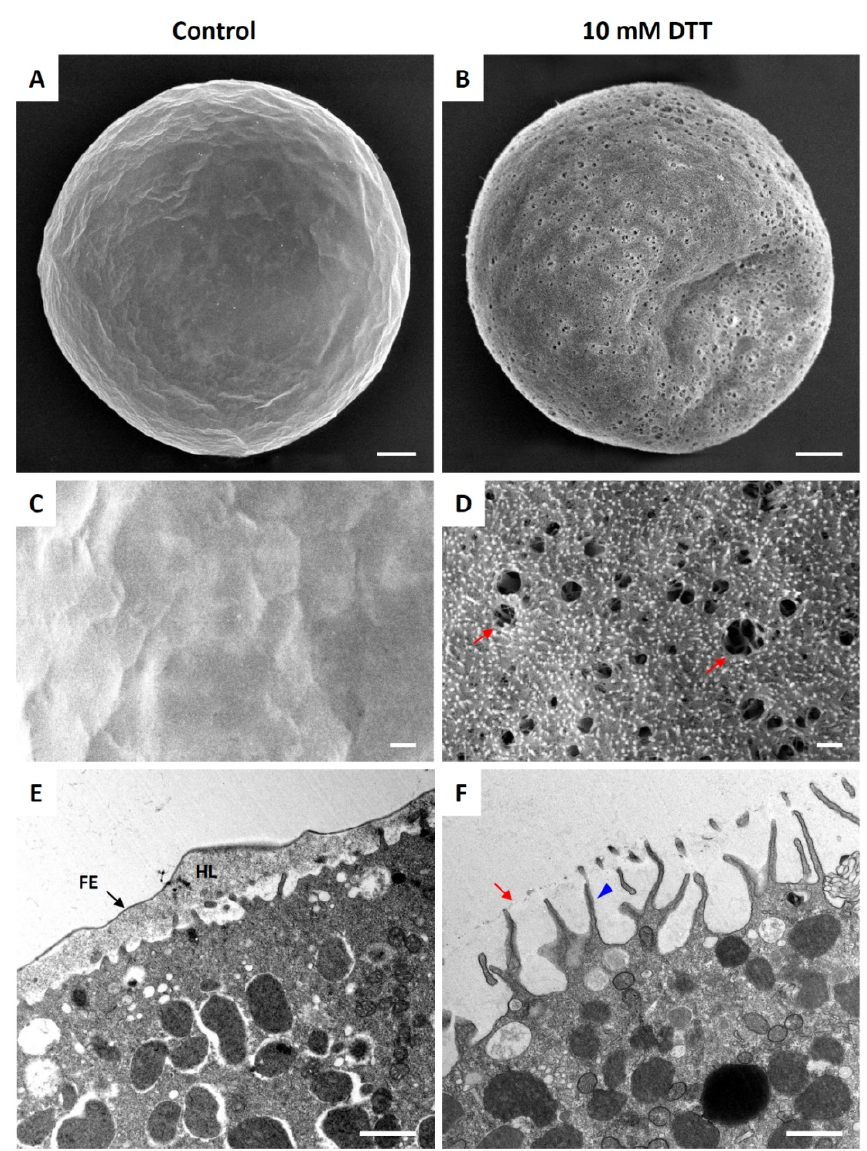
Figure 3. Ultrastructure of the egg surface at a later stage of fertilization. P. lividus eggs were fertilized and fixed 5 min later for SEM and TEM analyses. ( A , C , E ) Control eggs fertilized in NSW. ( B , D , F ) Eggs preincubated (10 min) and fertilized in seawater containing 10 mM DTT. Panels A − D show SEM images, while panels E and F represent results of TEM. Red arrows in panels D and F indicate the ruptured fertilization envelope. A blue arrowhead in panel F indicates the over-elongated microvilli. Scale bars: panels A and B, 10 μ m; all other panels, 1 μ m. FE, fertilization envelope (arrows); HL, hyaline layer.